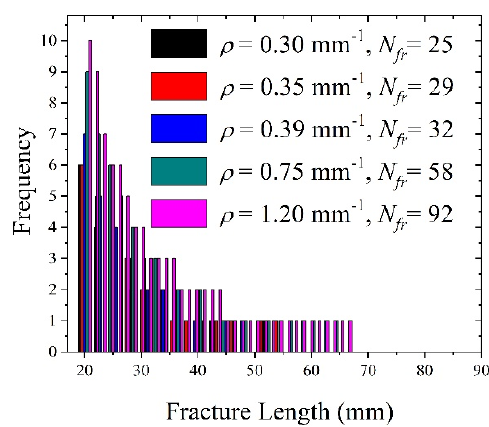
Figure 4. Fracture length frequency distribution of models with various fracture densities. The horizontal axis represents the fracture aperture, while the vertical axis represents the fracture frequency at a certain length for models with various fracture densities. The data are the average results measured from three models at each fracture density.